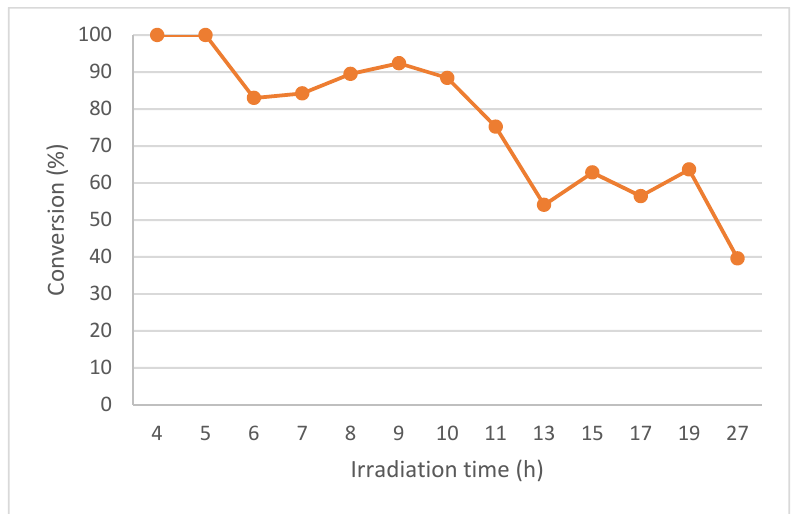
Figure 5. Conversion (%) for the continuous-photoflow of 1a at 20 mM with 4 h of residence time using the PQT6 reactor.